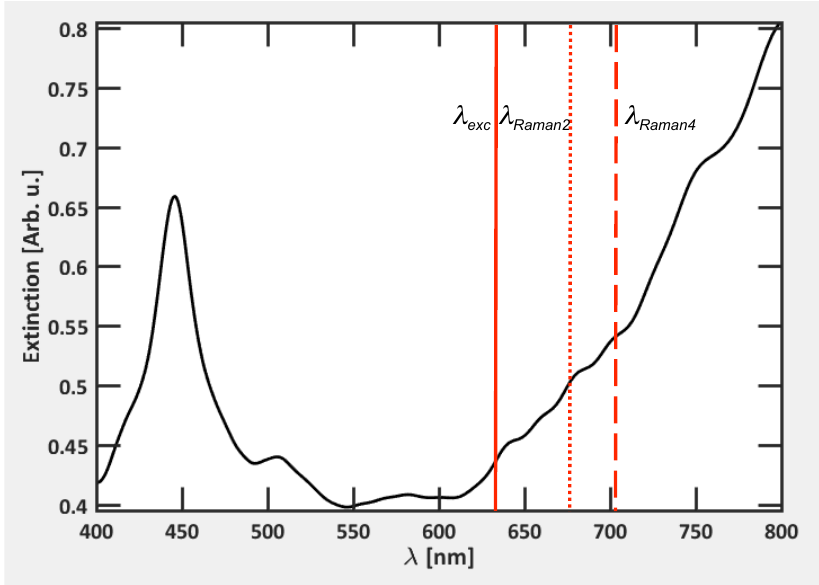
Figure 5. Calculated extinction spectrum of Al/Si nanopillars. λ exc corresponds to the excitation wavelength ( λ exc = 633 nm, continuous red line). λ Raman 2 and λ Raman 4 correspond to the Raman scattering wavelengths for the Raman shifts of 1025 cm − 1 and 1575 cm − 1 ( λ Raman 2 = 677 nm, dotted red line, and λ Raman 4 = 703 nm, dashed red line), respectively. For the sake of readability, only λ Raman 2 and λ Raman 4 are displayed, since λ Raman 1 and λ Raman 3 are very close to λ Raman 2